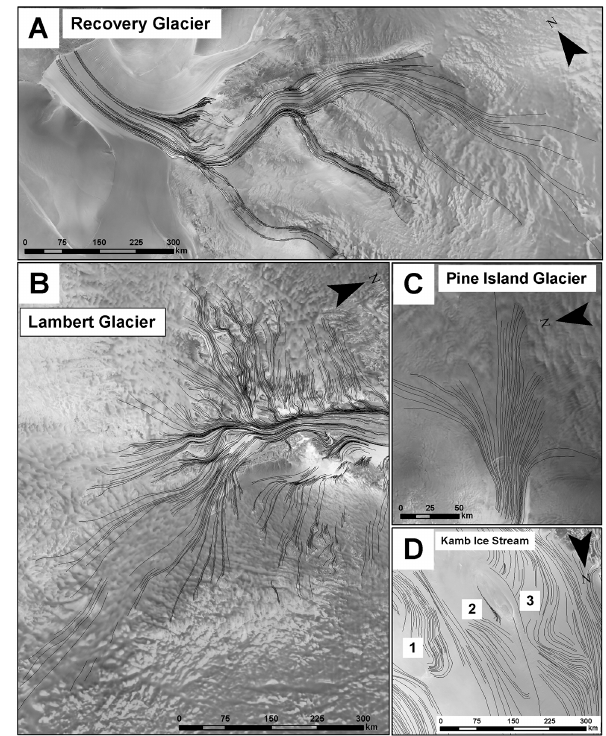
Figure 2. Detail of the surface structures of the Antarctic Ice Sheet in four key localities: (a) Recovery Glacier, (b) the Lam- bert Glacier–Amery Ice Shelf system, (c) Pine Island Glacier and (d) part of the Kamb Ice Stream (Ice Stream C) on the Ross Ice Shelf. Numbers 1 to 3 indicate disturbances in the longitudinal sur- face structures created when ice flow reorganised after ice-stream shutdown. Locations are marked in Fig.